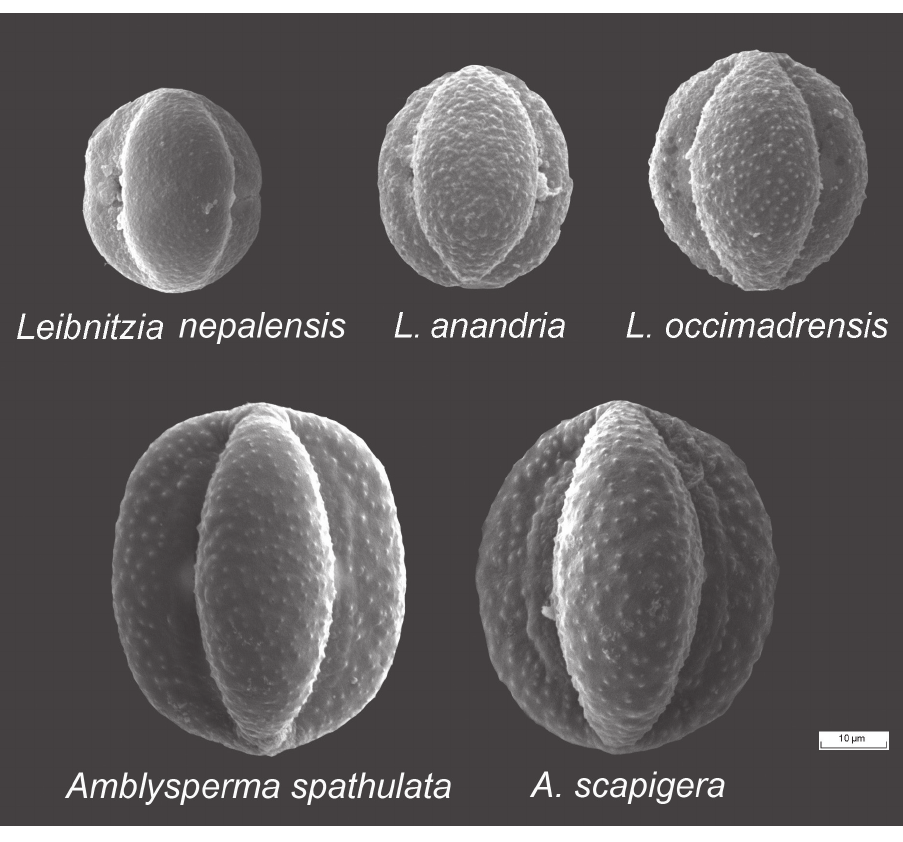
Figure 5. Pollen morphology of Leibnitzia and Amblysperma